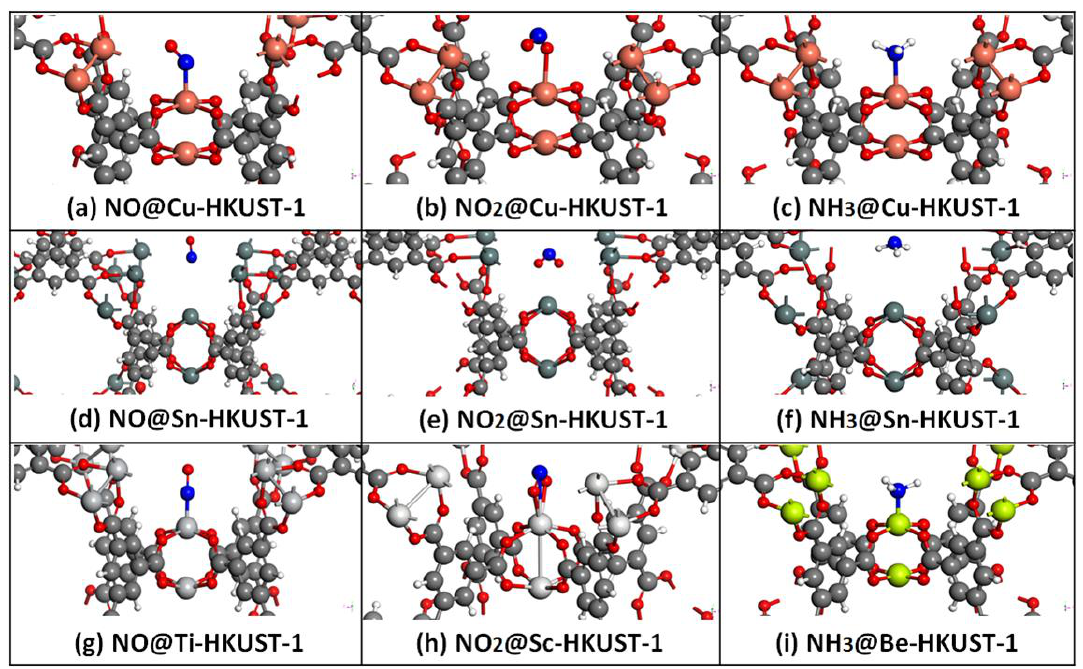
Figure 1. Representative adsorption structures near the secondary building units (SBUs) on selected metal organic frameworks (MOFs): ( a ) NO on Cu-HKUST-1, ( b ) NO 2 on Cu-HKUST-1, ( c ) NH 3 on Cu-HKUST-1, ( d ) NO on Sn-HKUST-1, ( e ) NO 2 on Sn-HKUST-1, ( f ) NH 3 on Sn-HKUST-1, ( g ) NO on Ti-HKUST-1, ( h ) NO 2 on Sc-HKUST-1, and ( i ) NH 3 on Be-HKUST-1. The largest spheres are metal atoms. White, red, blue, and grey spheres are H, O, N, and C atoms with increasing size, respectively.